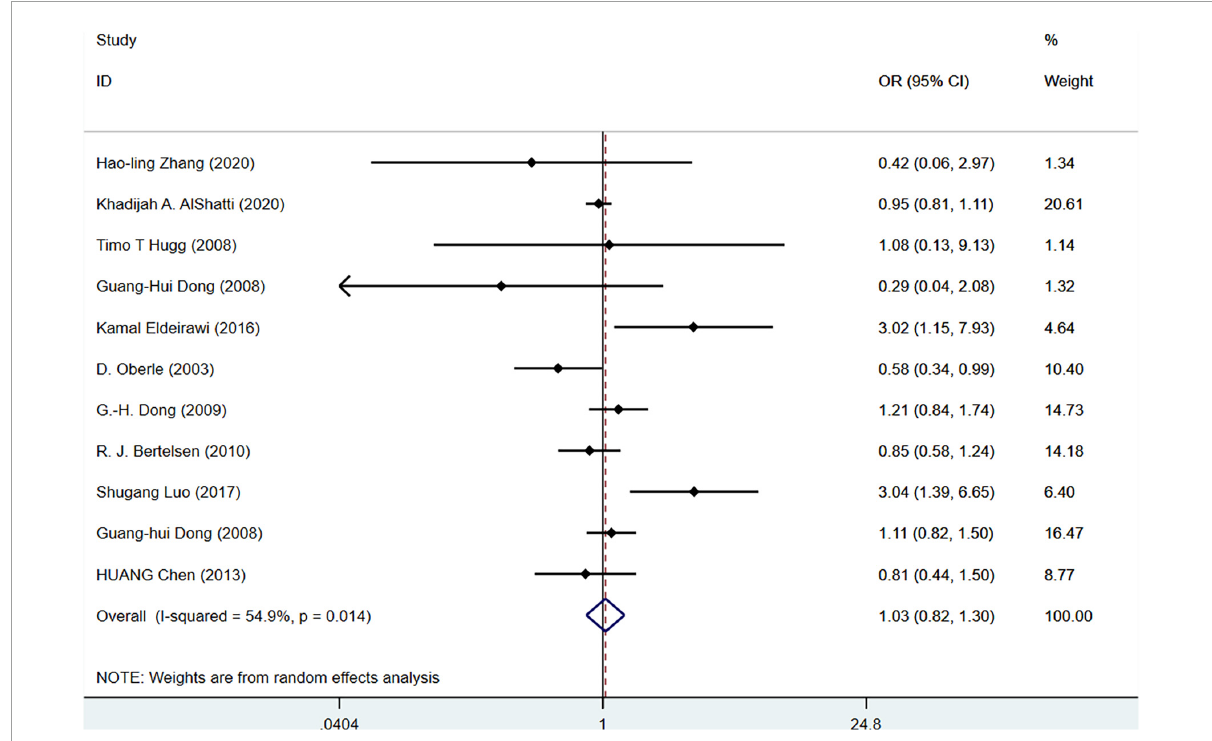
FIGURE5 Forest plot of the association between furry pet ownership and childhood asthma.